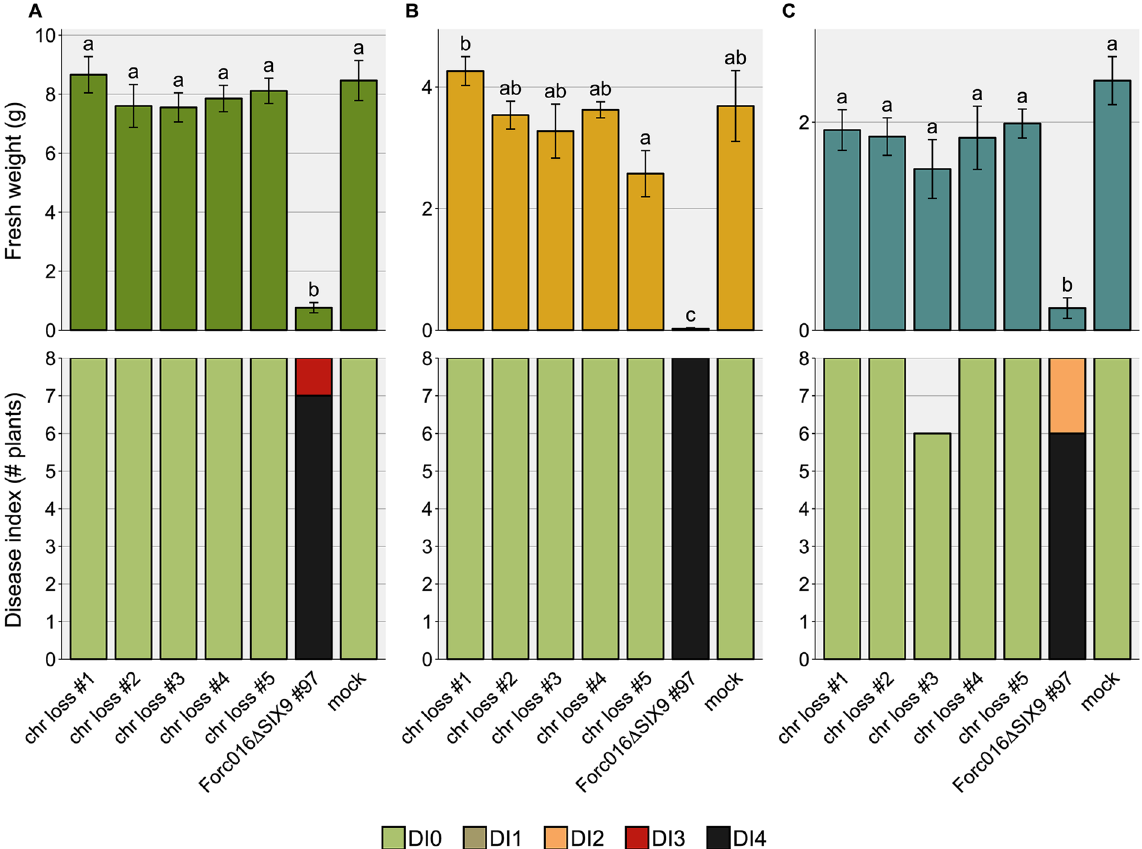
Figure 9. Forc016 strains without chr RC are completely avirulent. Fresh weight ( ± S.E.) and disease index (DI) of ( A ) cucumber, ( B ) melon and ( C ) watermelon plants were scored 14 days post inoculation. An ANOVA followed by a Tukey HSD test (p < 0.05) was performed to determine the significance of differences in the fresh weight measurements (significance categories shown with letters above the bars). Under the tested conditions (10 7 spores/ml, 20 °C), none of the chromosome loss strains were able to cause disease symptoms in cucurbit plants, while their parent strain (Forc016 ∆ SIX9 #97)